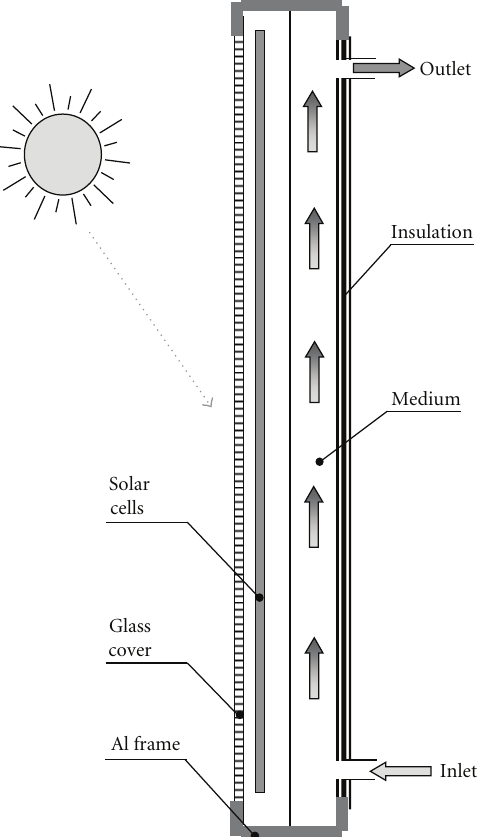
Figure 2: PV/T system